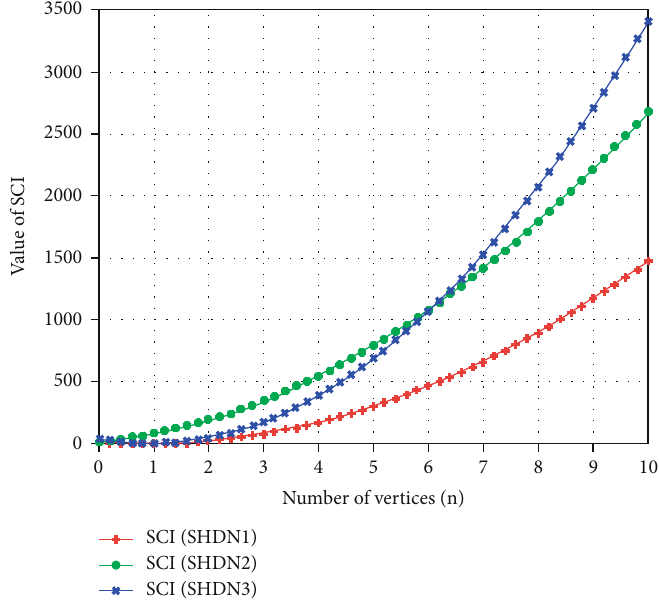
n Þ , Γ n Þ , and Γ n Þ using 2D graphs of 1 ð 2 ð 3 ð